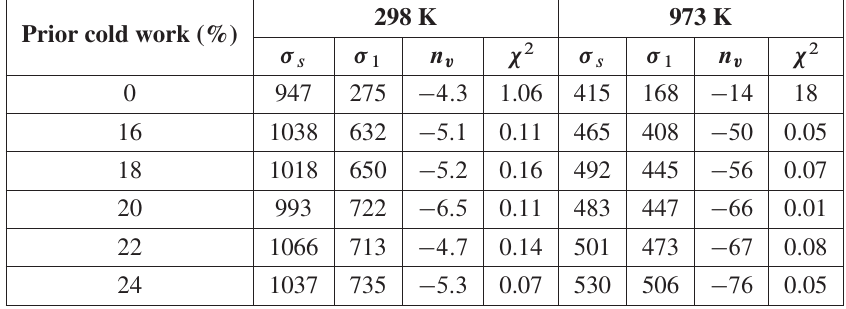
Table 3. Parameters derived from Voce equation for test temperatures of 298 K and 973 K.